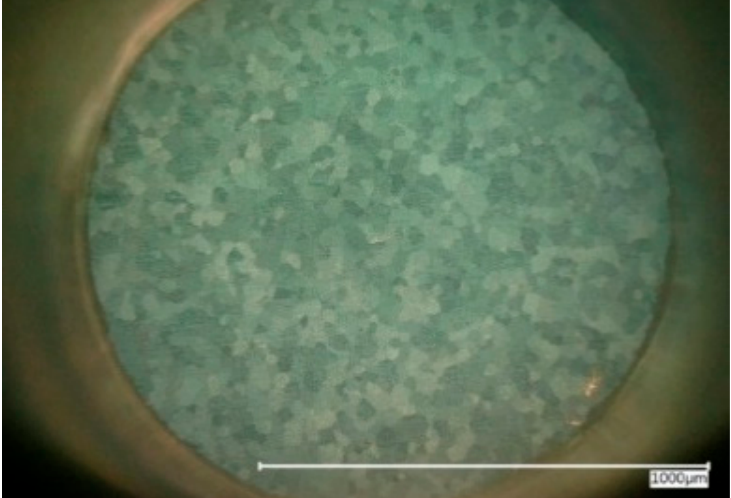
Figure 3. The cp Mg surface as seen through video-optical-electrochemical cell, polarized lighting.